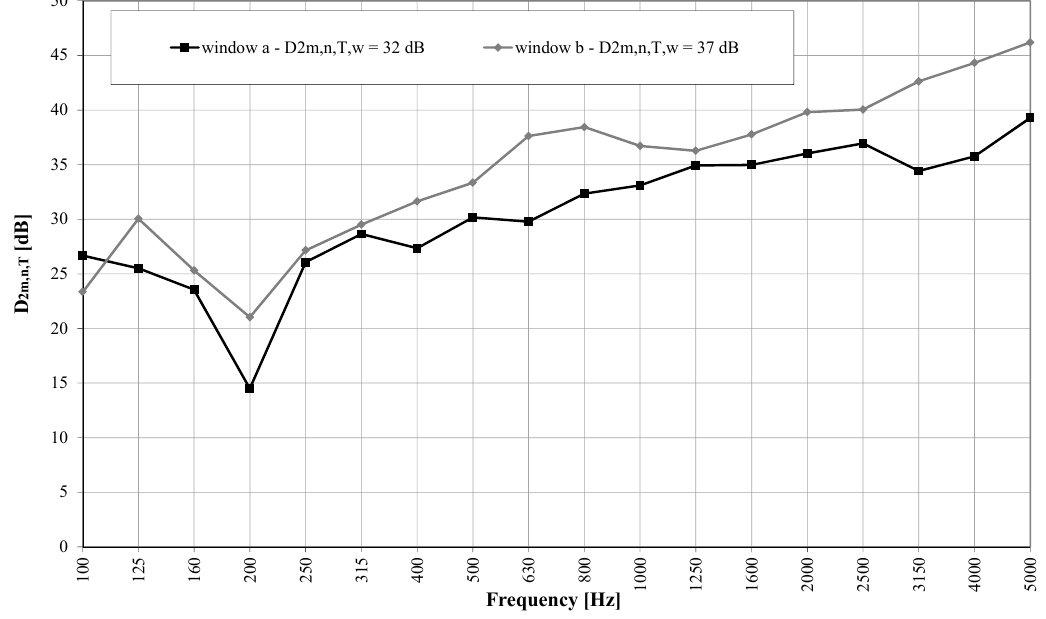
): influence of wrong installation for the same 2m,n,T